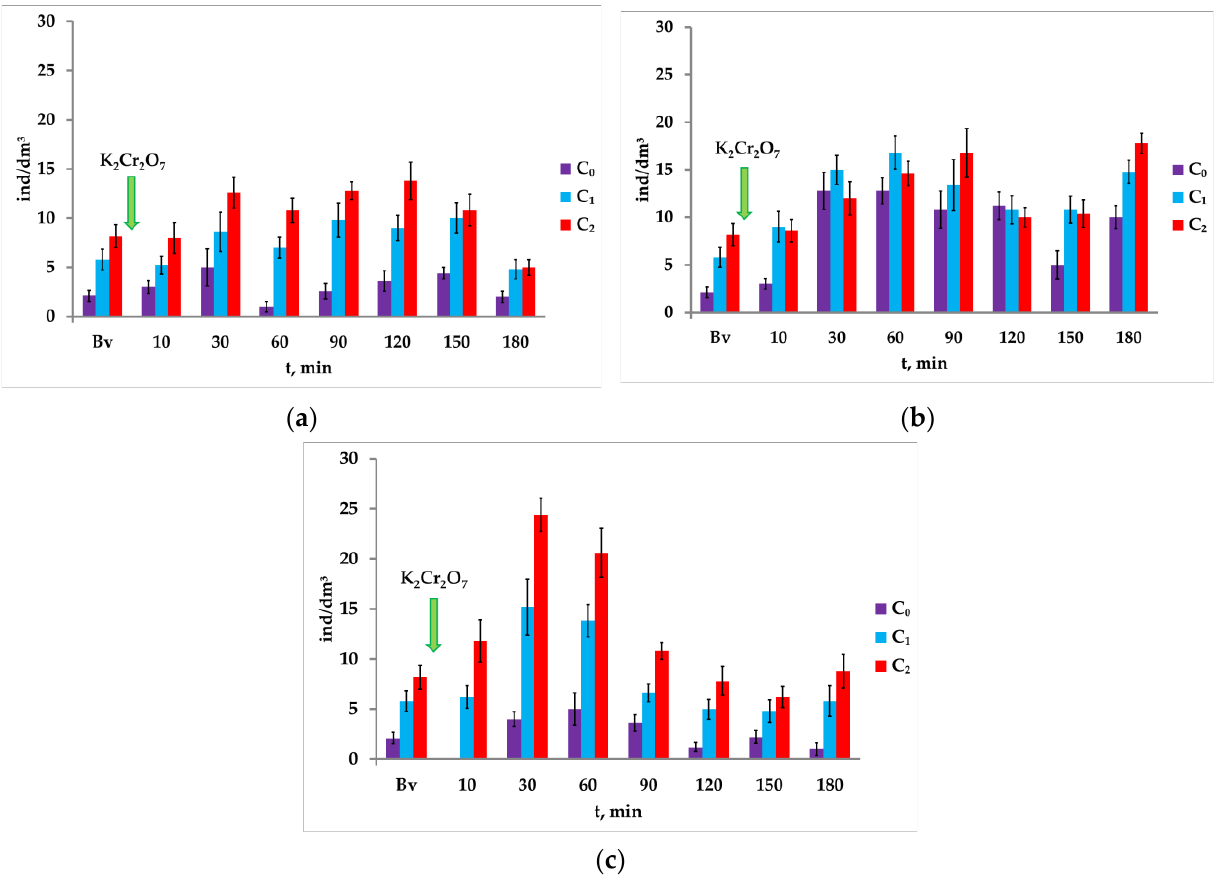
Figure 4. Response of A. salina to paired photostimulation in the presence of K 2 Cr 2 O 7 at the concentration of 4.0 mg/dm 3 ( a ), 8.0 mg/dm 3 ( b ), 16.0 mg/dm 3 ( c ). C 0 — average concentration of crustaceans before photostimulation; C 1 — average concentration of crustaceans at photostimulation with intensity I 1 (1150 lx); C 2 — average concentration of crustaceans at photostimulation with intensity I 2 (3450 lx); Bv — background value; Green arrow — pollution.